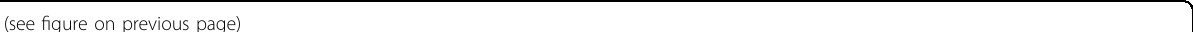
Fig. 1 Coronary endothelial cells contribute to endocardial cells after genetic depletion of endocardium. a Schematic showing knock-in strategy for generating Npr3-tTA allele. b Whole-mount fl uorescence image of P2 heart. c Immunostaining for tdT and VE-Cad on heart sections from ( b ). d Schematic showing knock-in strategy for generation of Cdh5-LSL-tdT-DTR allele. e Whole-mount fl uorescence image of E10.5 embryos. f , g Immunostaining for tdT and VE-Cad ( f ) or DTR ( g ) on E10.5 Cdh5-tdT-DTR;Actb-Cre embryonic sections. h Schematic showing genetic ablation of endocardium-derived endothelial cells. i Schematic showing the experimental strategy. j Whole-mount fl uorescence image of P5 heart from Npr3- tTA;TetO-Cre;Cdh5-LSL-tdT-DTR mice treated with or without DT. k , l Immunostaining for tdT and CD31 on P5 heart sections treated without DT ( k ) or with DT ( l ). Arrowheads indicate connection between coronary vessels and the endocardium. m Schematic showing the experimental strategy for simultaneous coronary vessel tracing and endocardial cell depletion. n Immunostaining for GFP and CD31 on P14 heart sections treated with DT. Arrowheads, GFP + CD31 + cells. Right panel shows the quanti fi cation of the percentage of GFP + endocardium. Data are means ± SEM; n = 8. o Immunostaining for GFP and PLVAP on P14 heart sections treated with DT. Arrowheads, GFP + PLVAP + cells. p Cartoon image showing coronary endothelial cells convert to endocardial progenitors after depletion of endocardium-derived cells. Scale bar 1 mm (yellow), 100 µm